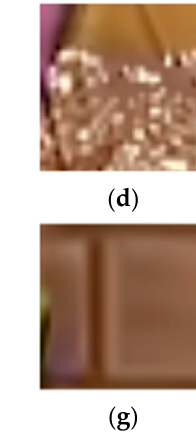
Figure 11. Reconstructed results of complex and monotonous areas by the proposed method: ( a ) Blow- ingBubbles —416 × 240; ( b ) original of complex area; ( c ) QP27; ( d ) QP37; ( e ) original of monotonous area; ( f ) QP27; ( g ) QP37.